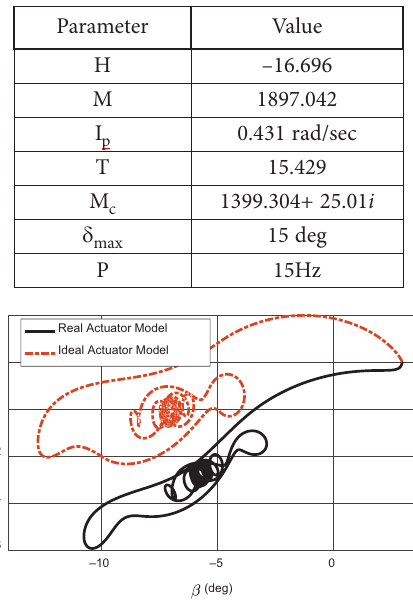
Figure 4. Rolling airframe planner motion representation in presence of real and ideal ON-OFF actuator models